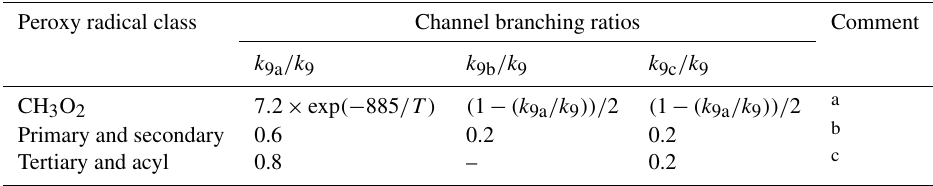
Table 13. Branching ratios assigned to parameterized permutation reactions of RO 2 (see text). Peroxy radical